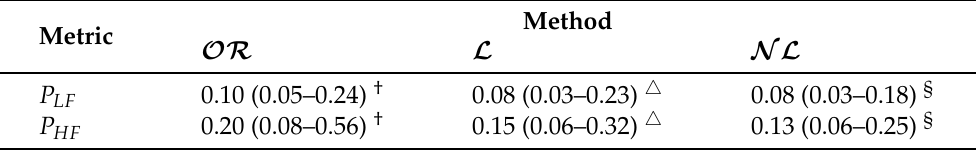
Table 9. Relative error (%) of frequency-domain computed via Lomb’s method metrics from Ap- ple Watch dataset. †: Significant differences ( p < 0.05) between OR and L . (cid:52) : Significant differences ( p < 0.05) between L and N L . §: Significant differences ( p < 0.05) between N L and OR